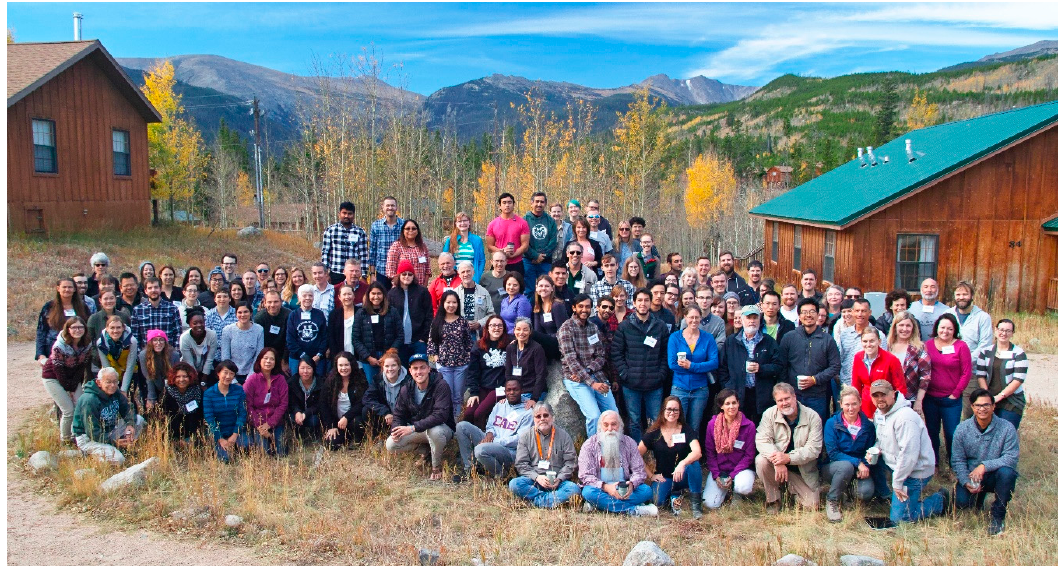
Figure 1. Attendees at the 18th annual Rocky Mountain Virology Association meeting in the Mountain Campus of Colorado State University.